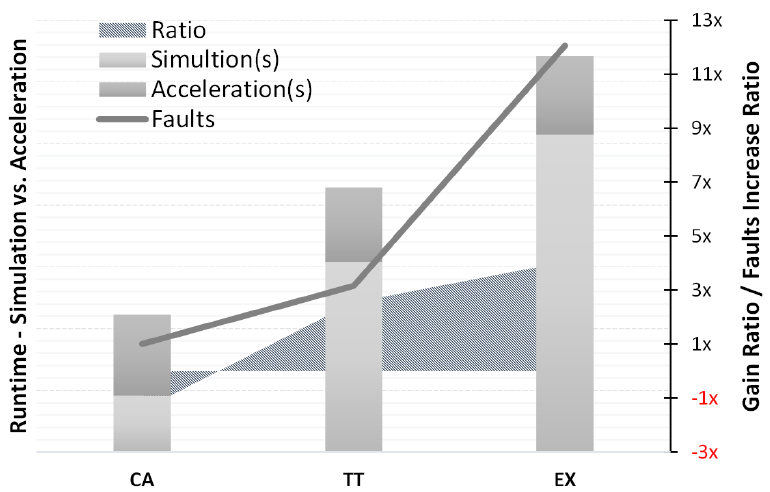
Figure 8. Injection runtime of each test